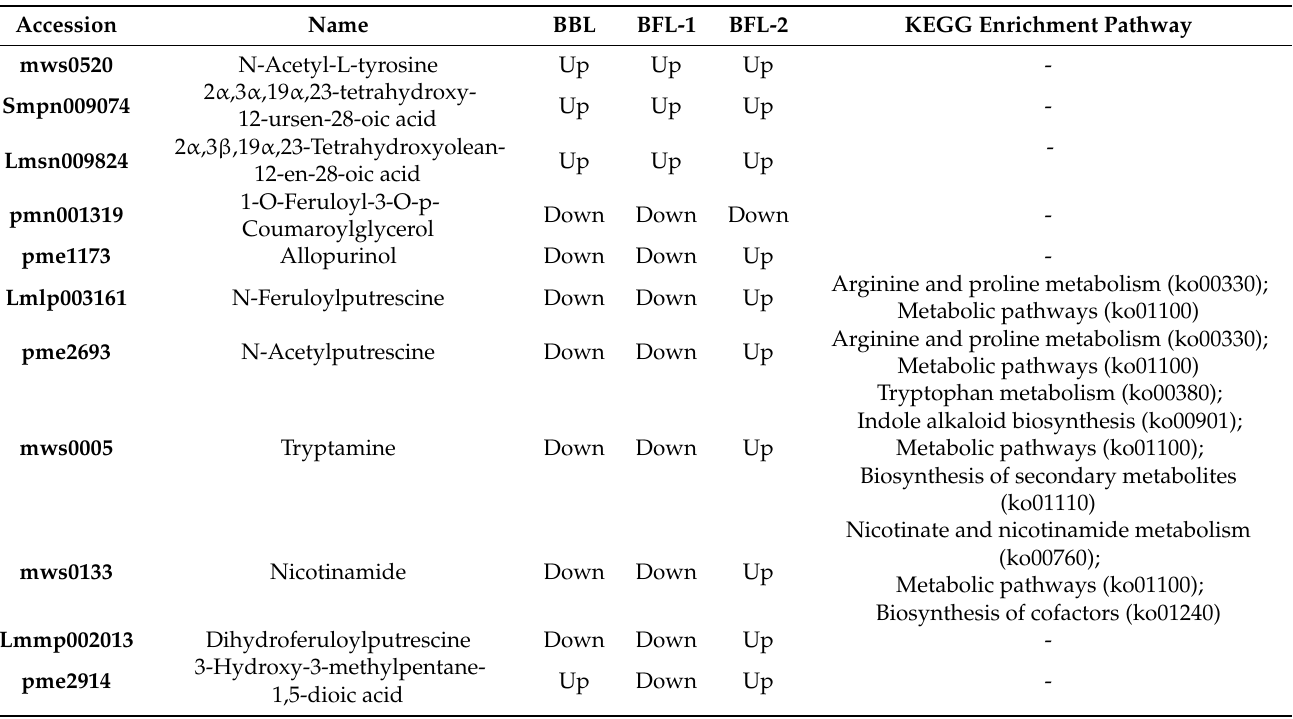
Figure 5. Venn diagram showing the number of overlapping DEPs ( A ) and DAMs ( B ) in pairwise comparisons between three groups of GM/non-GM maize seeds. Table 4. The DEPs among the three GM maize lines. Table 5. The DAMs among the three GM maize